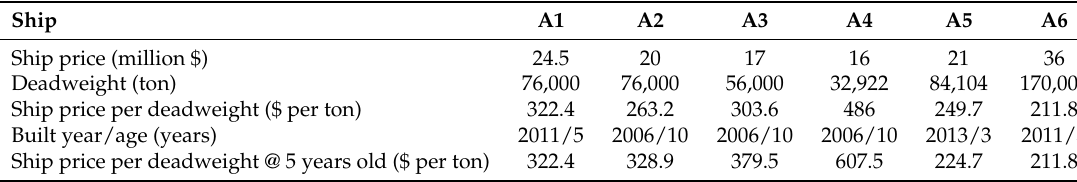
Table 14. An overview to